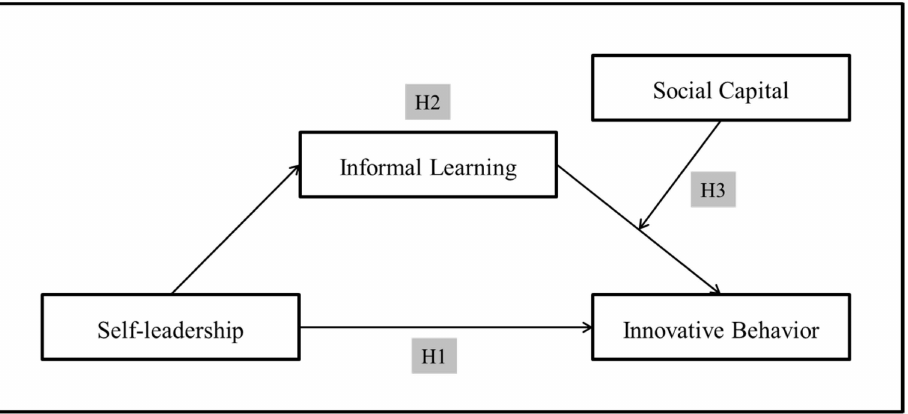
Figure 1. Research